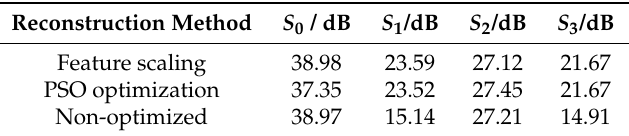
Table 1. The average PSNR values of the four Stokes parameters reconstructed based on feature scaling, PSO optimization and